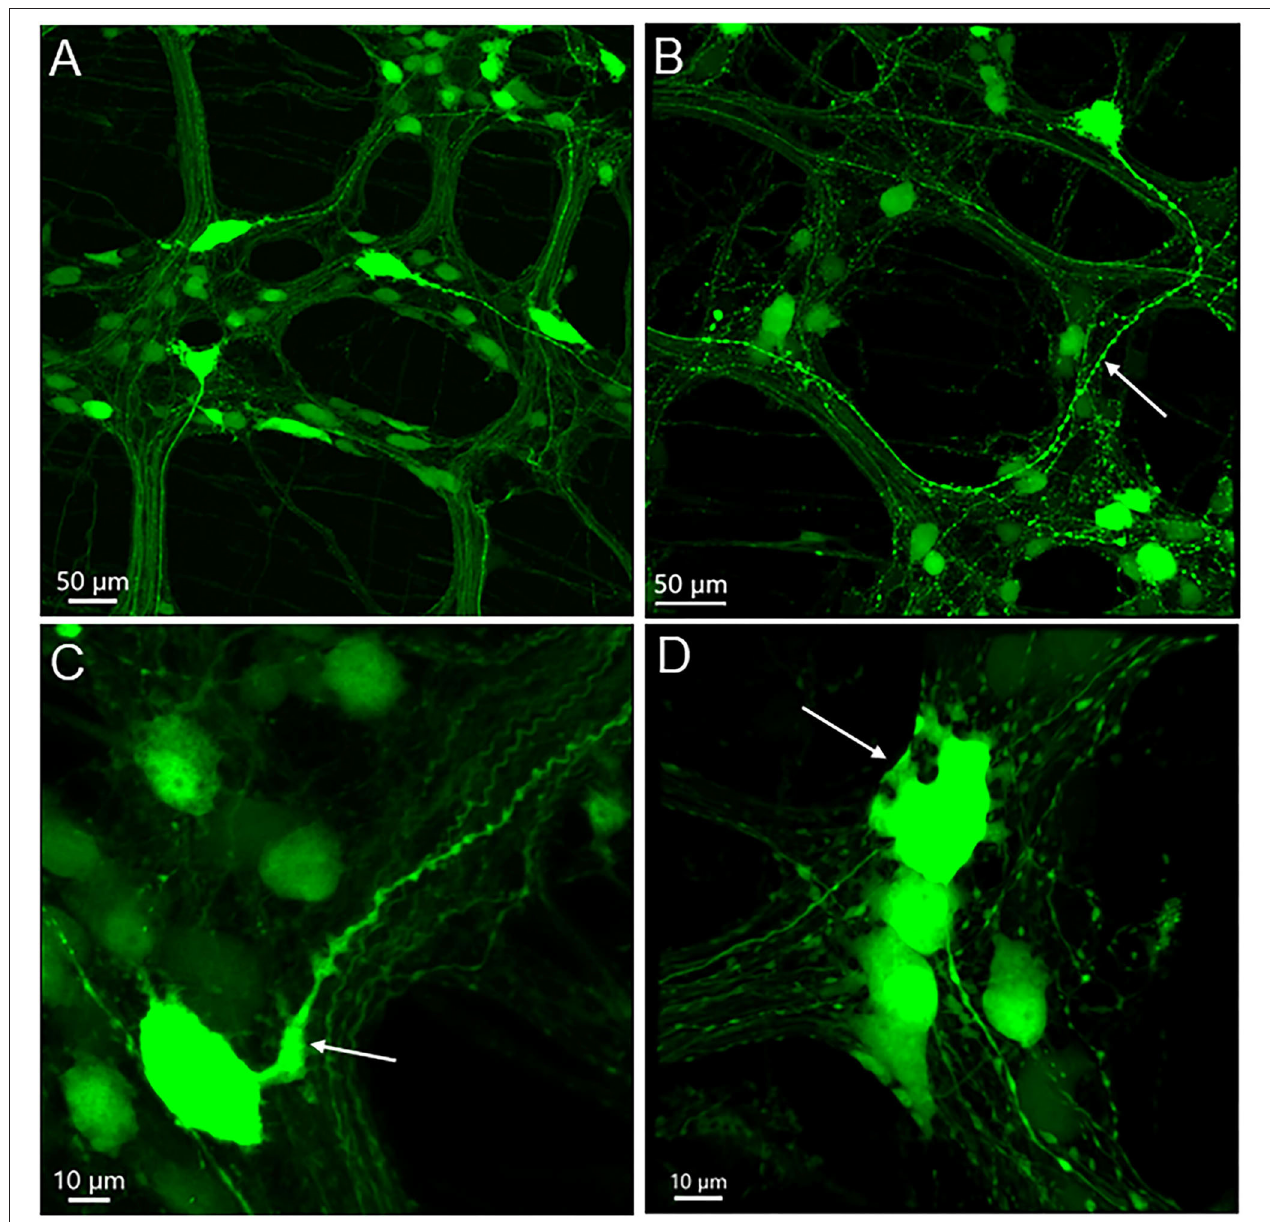
FIGURE 3 | AAV9-transduced neurons in the myenteric plexus in whole mount preparations of the mouse proximal colon. AAV9-CAG-GFP was retro-orbitally injected at 3.3 x 10 11 GC/mouse 3 weeks before. (A) Axons of a few large neurons project out of the ganglia in different directions, and many neurons are small and medium in size without labeled processes. (B) One neuron has a large soma and a thick varicose axon (arrow). (C) The axon of a big neuron has enlarged initial part (arrow) and varicosities en route . (D) The arrow points to some short thick dendrites of one neuron at the edge of one ganglion. Scales as indicated in each